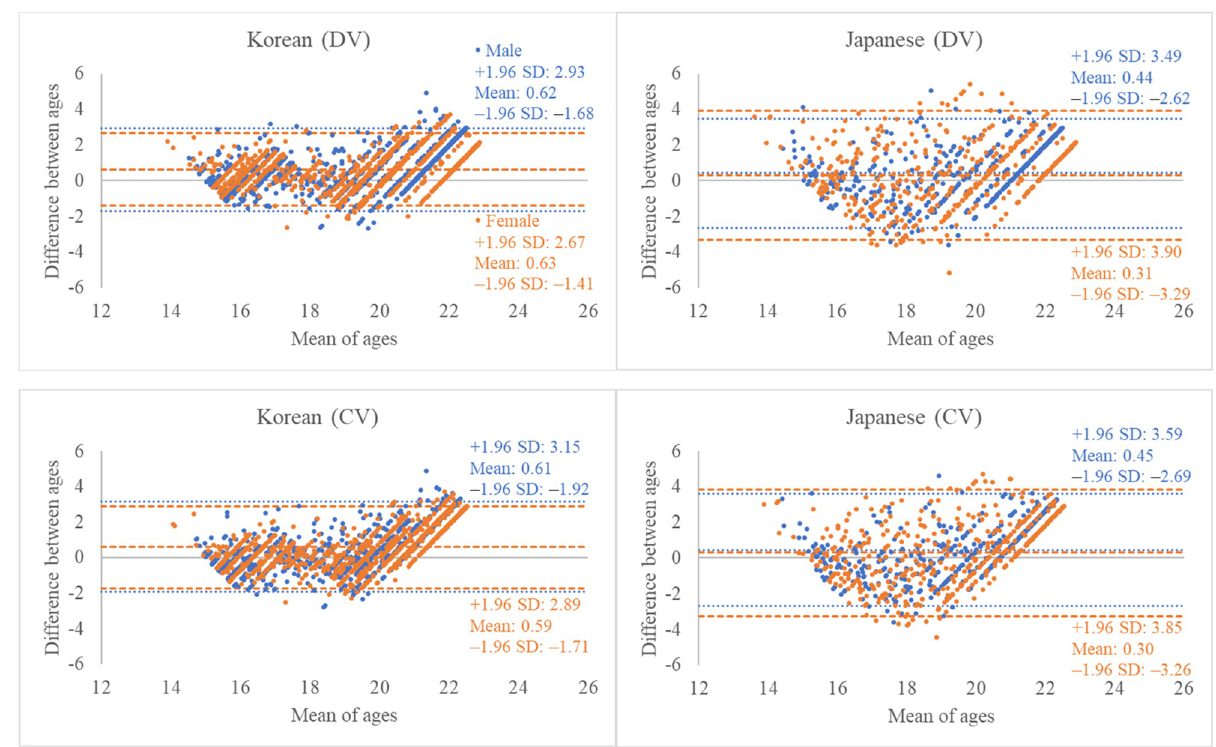
Fig 3. Bland–Altman plot of the difference between chronological and estimated ages. The age was estimated based on the maturity of M2s and M3s in both jaws. The difference was calculated by subtracting the estimated age from chronological age. DV, discrete variable; CV, continuous variable. Blue represents male, and orange represents female.